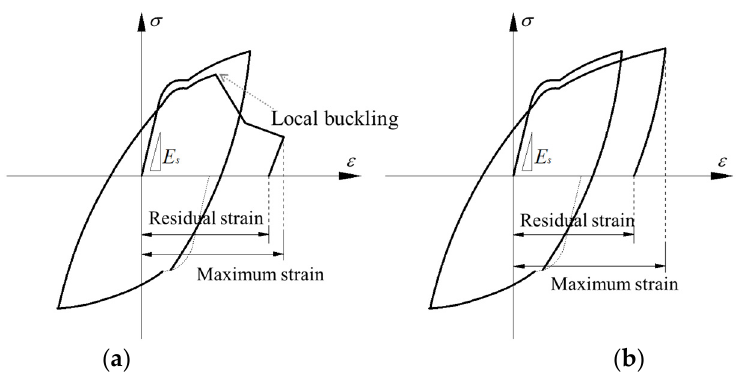
Figure 2. Stress–strain relation of thin ‐ walled steel sections. ( a ) Model with post ‐ buckling deterioration; ( b ) Model without post ‐ buckling deterioration.